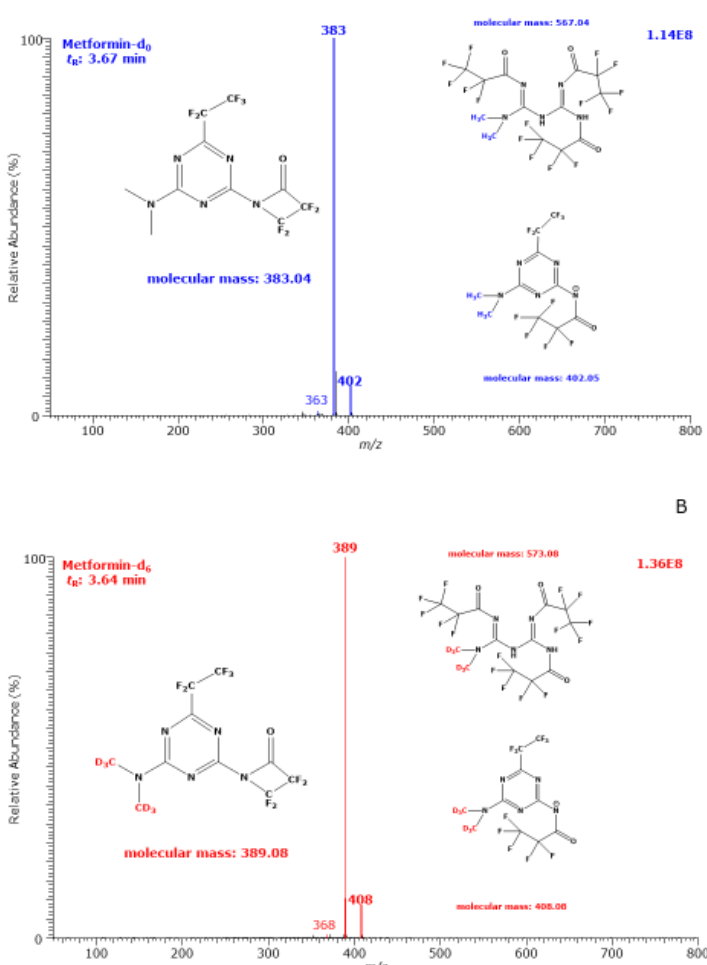
Figure 1. GC–MS spectra of ( A ) synthetic metformin-d 0 (50 nmol) and ( B ) synthetic metformin-d 6 (50 nmol) obtained by separate derivatization each of 100- µ L aliquots of freshly prepared PFPA solution in ethyl acetate (1:4, v/v ) and heating for 30 min at 65 ◦ C. After extraction with toluene (1 mL), each 1- µ L aliquot (corresponding to 50 pmol assuming a total yield of 100%) was injected and the negative-ion chemical ionization (NICI) mass spectra were acquired in the mass-to-charge ( m/z ) range 50–800 (1 scan/s). Inserts indicate the proposed structures of the intact derivatives and of the most intense ions m/z 383 and m/z 389.